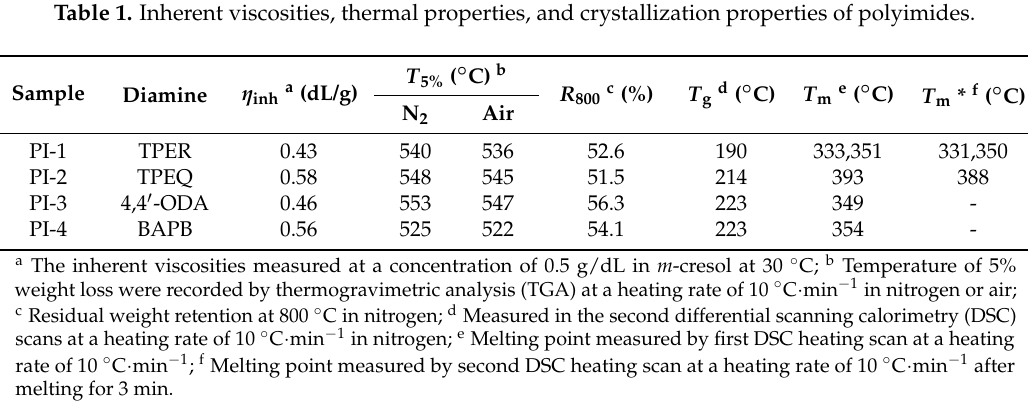
Table 1. Inherent viscosities, thermal properties, and crystallization properties of polyimides.